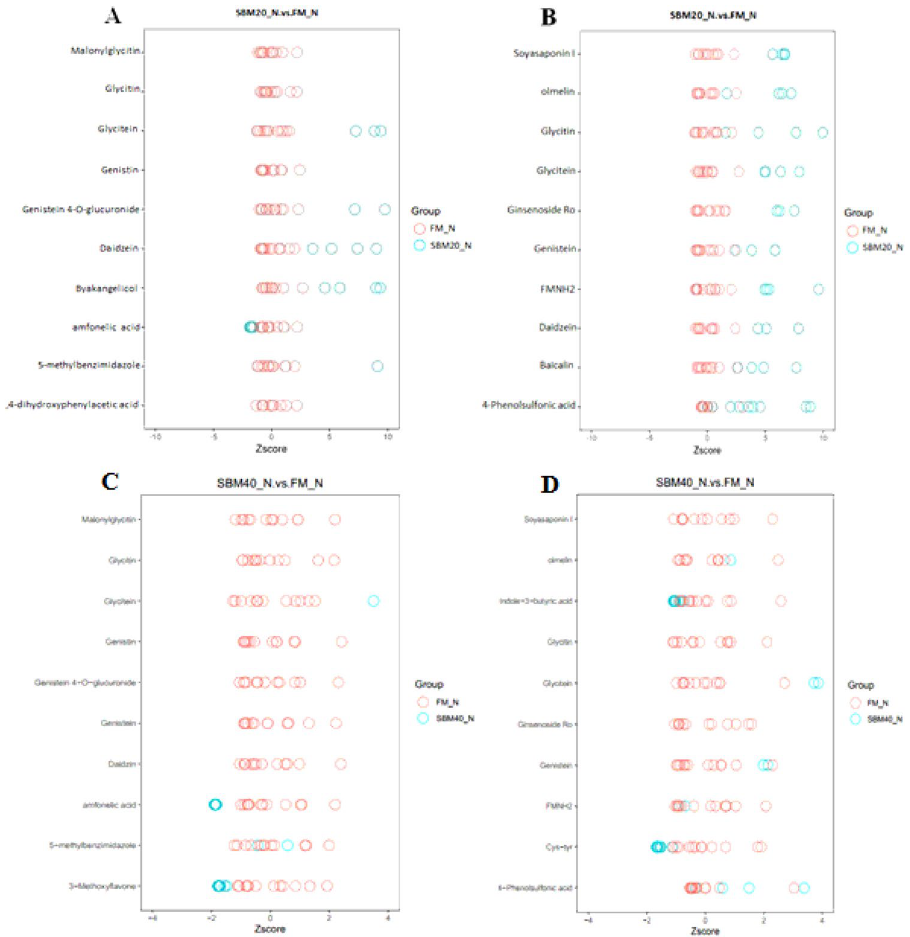
Figure 16. z -Score plot of the potential biomarkers for comparison between the FM, SBM20_N, and SBM40_N groups in positive ( A , C ) and negative ( B , D ) modes (n = 12). Note: FM_N, fish meal control group; SBM20_N, 20% SBM protein replacement level to FM protein; SBM40_N, 40% SBM protein replacement level to FM